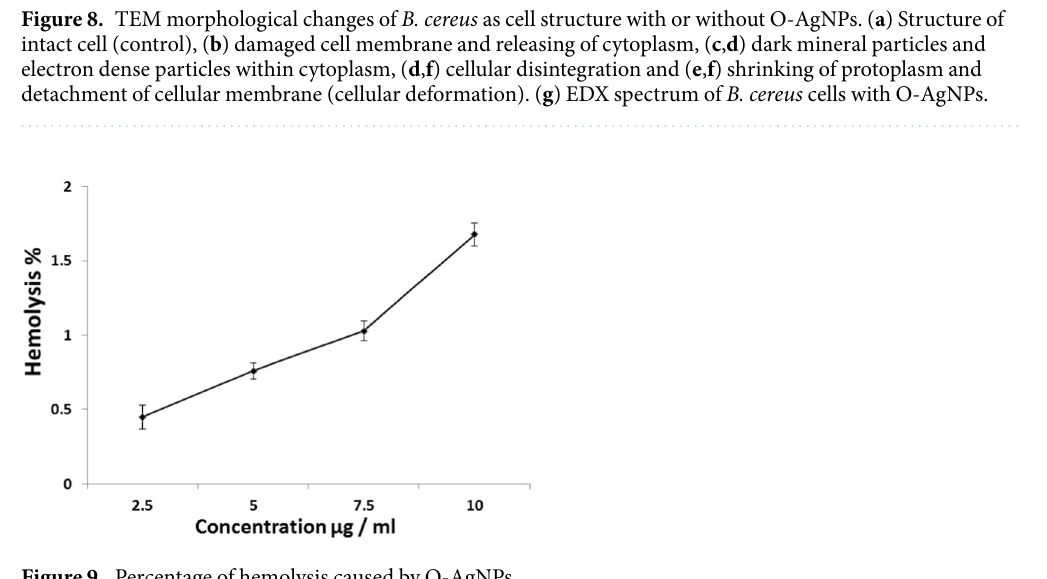
( − ve control) exhibited 98.64% and 0.011% hemolysis, respectively. For explaining the mode of action of TTX- 100 hemolytic potentially, firstly the inclusion of TTX-100 molecules into RBCs membrane resulted in reducing the molecular packing which leads to an increase in permeability causing haemoglobin leakage. Afterward, the